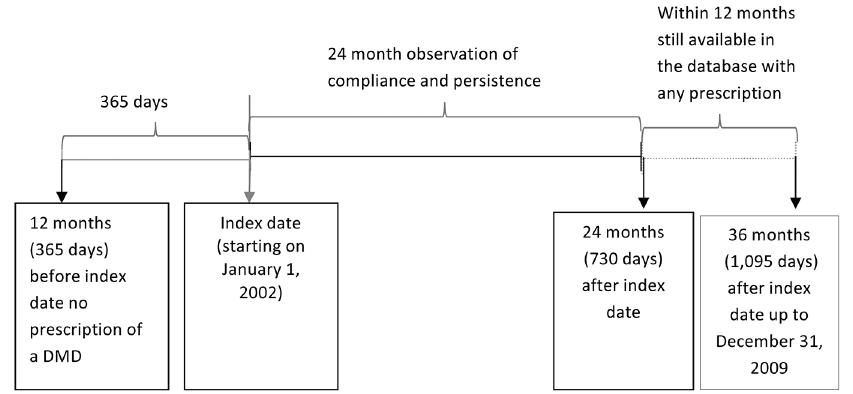
Fig 1. Cohort definition and observation period of the